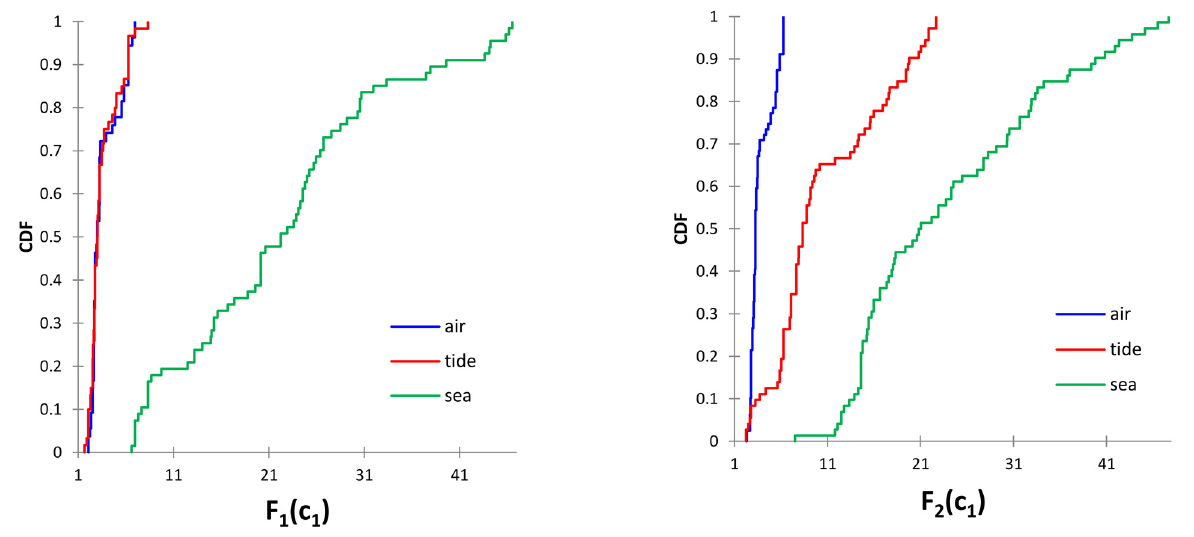
Figure 10. Empirical CDF of the NiTi-1 and NiTi-2